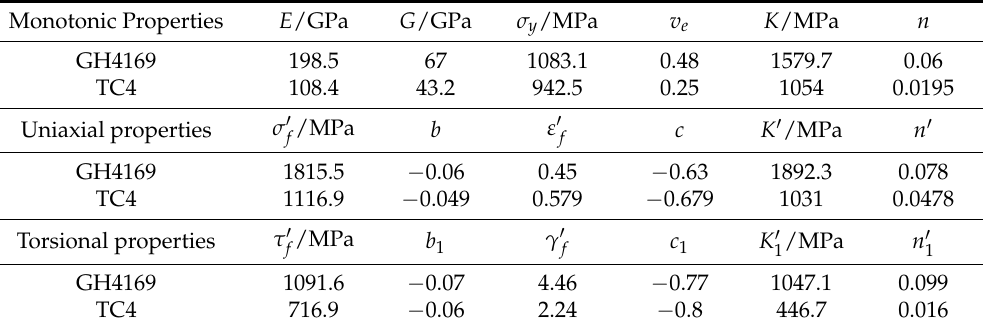
Figure 5. Correlation between the tested life and equivalent strain. Table 1. The material properties of GH4169 and TC4 at room temperature.